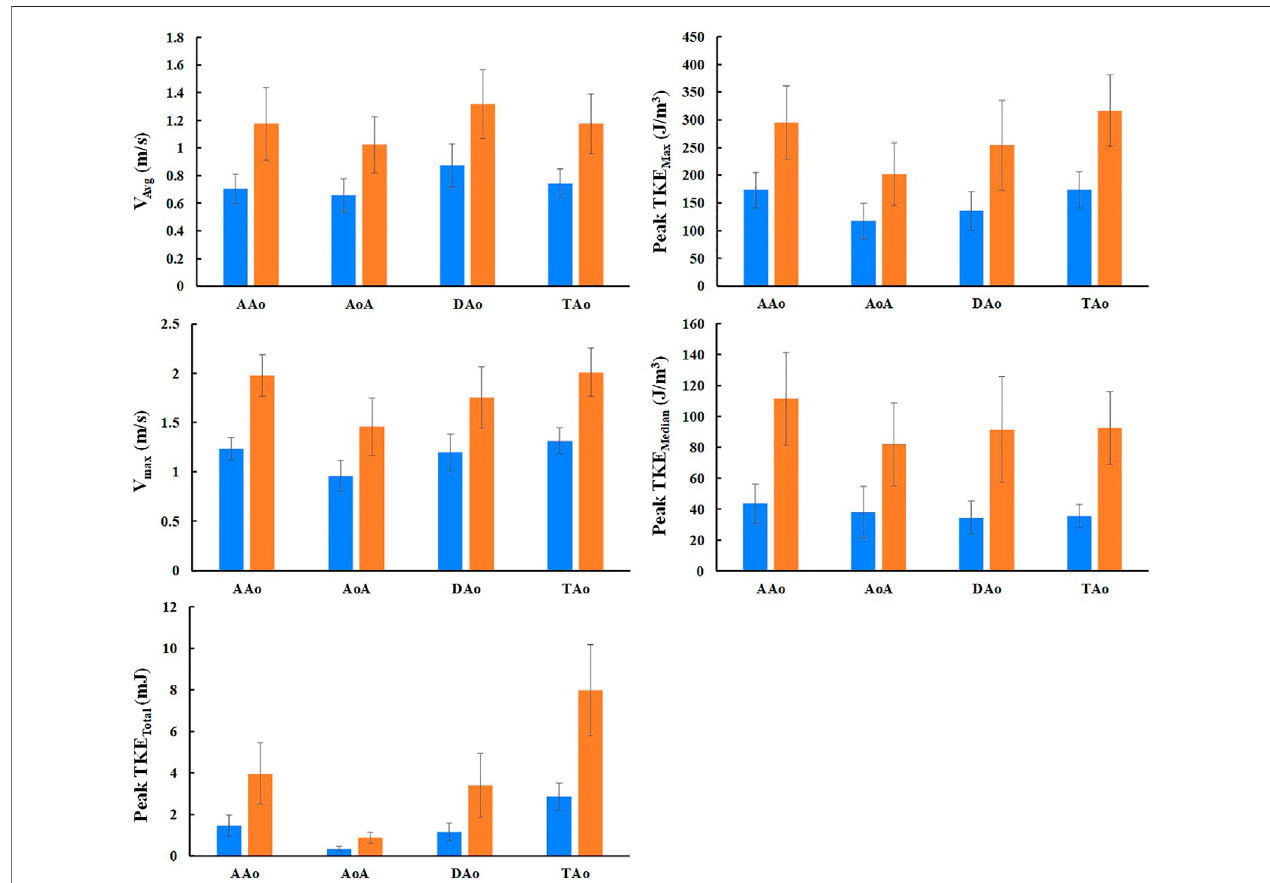
FIGURE 4 | Graphic representation of all hemodynamic parameters, mean and SD. Blue bars are values at rest and orange bars are values with dobutamine infusion; AAo, ascending aorta; AoA, aortic arch; DAo, descending aorta; TAo, thoracic aorta.